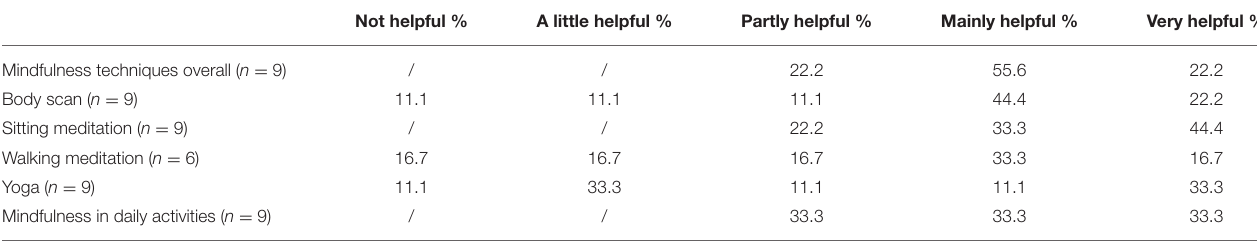
TABLE 2 | Evaluation of the different exercises. Not helpful % A little helpful % Partly helpful % Mainly helpful % Very helpful %